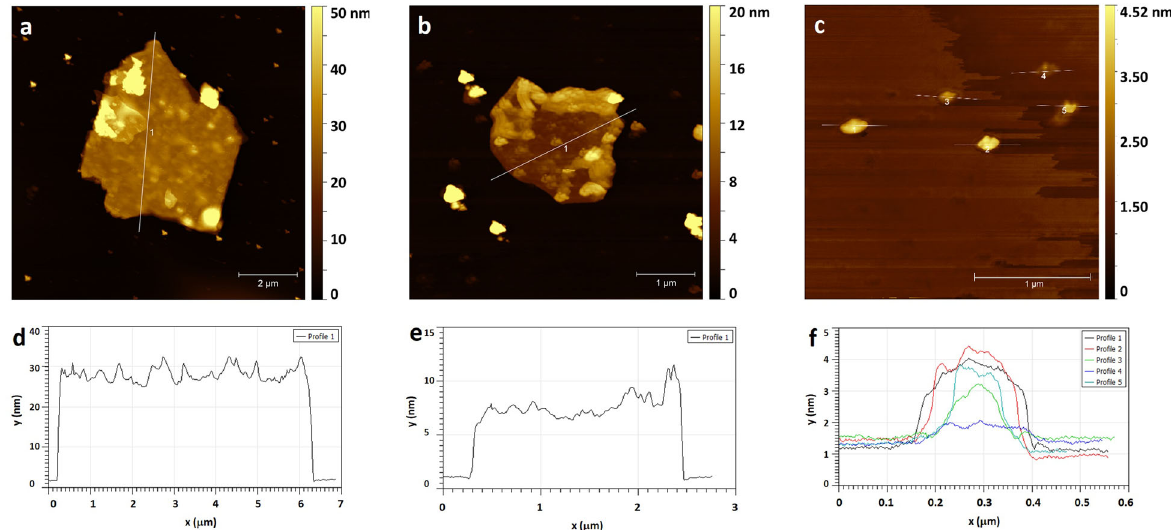
Fig. 2 Topographic imaging. AFM images of the as-exfoliated TaS 2 nanosheets ( a, b ), nanoparticles ( c ), and their corresponding height pro fi les ( d – f